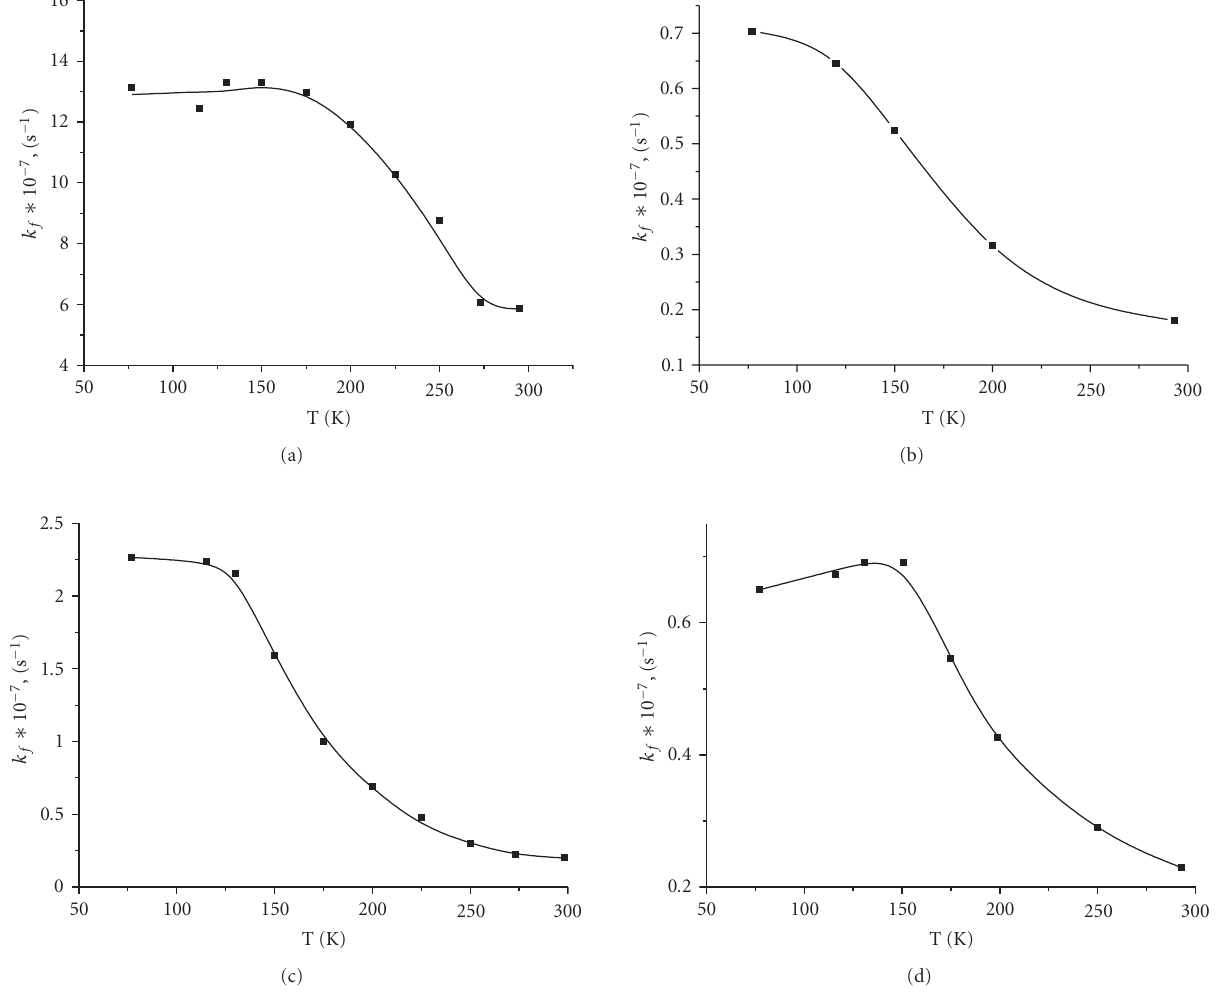
Figure 6: The dependence of the e ff ective radiative rate constant on the temperature in ethanol for I (a), II (b), III (c), IV (d) compounds.